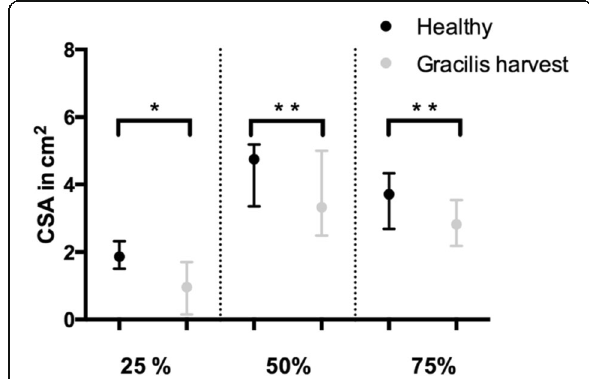
Fig. 3 Comparison of the CSA of the gracilis muscle between limbs with gracilis tendon harvest (Gracilis harvest) and contralateral limbs (Healthy) at 25%, 50% and 75% of the length of the femur from distal. Results presented as median with IQR. * p < 0.05; * * p <